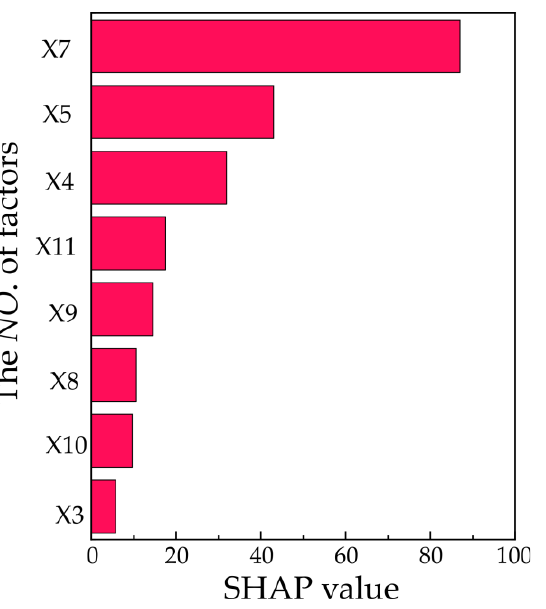
Figure 6. The mean of the absolute SHAP values for each factor across the whole dataset. Two typical single prediction plots using the XGBoost model are shown in Figure 7.